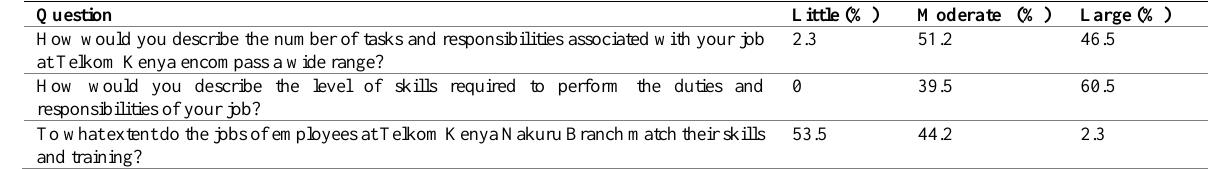
Table 6: Respondents views on Job